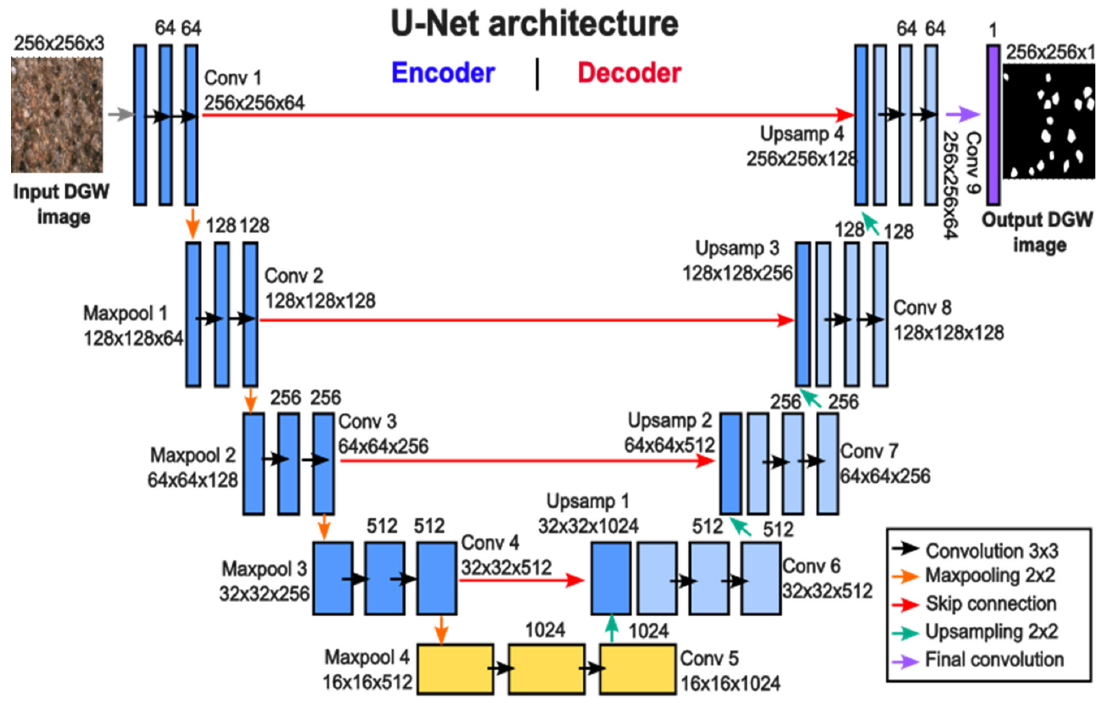
Figure 2. U-Net architecture for DGW image semantic Figure 2. U ‐ Net architecture for DGW image semantic segmentation.